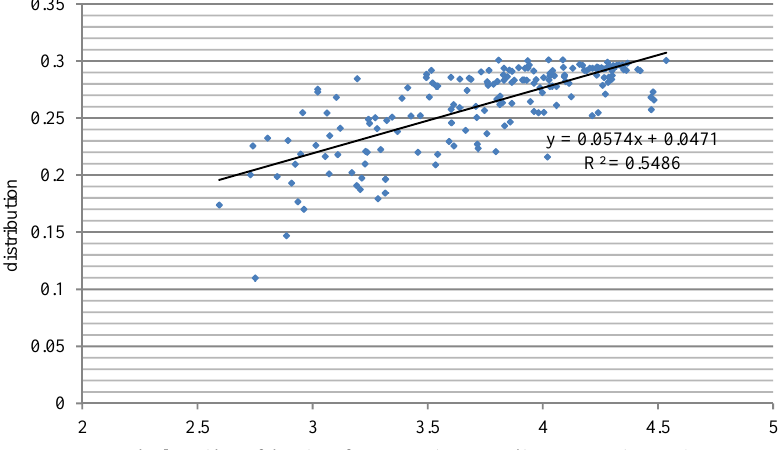
Source: own calculations based on ICP data. Figure 2. Linear regression for link "the absolute size of consumer spending — a measure of diversity of consumer spending (between-group entropy)"